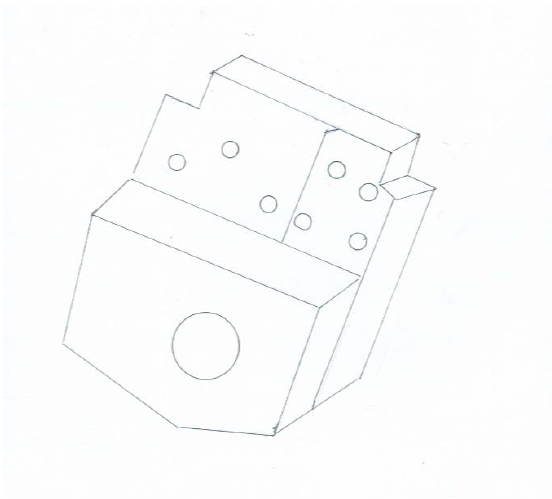
Figure 1. Line drawing of the keel joint with the carved seven dots of the Quanzhou Bay shipwreck.